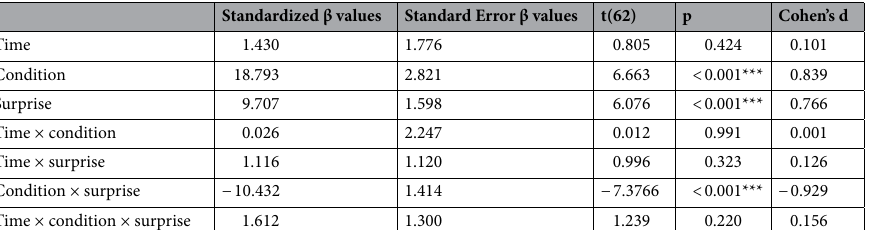
Standardized β values Standard Error β values